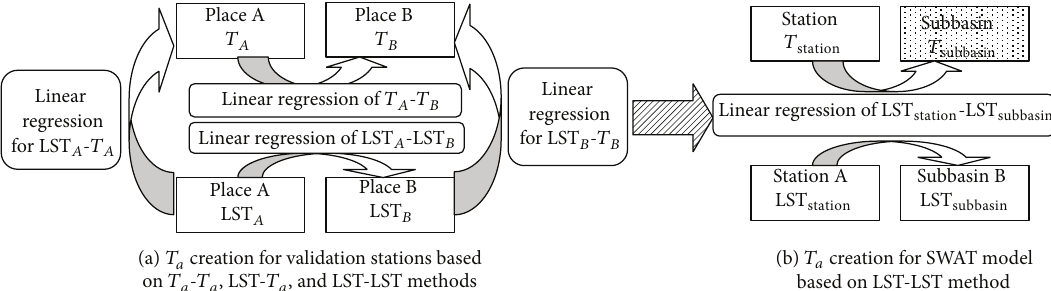
Figure 2: Diagram of 𝑇 𝑎 creation methods based on 𝑇 𝑎 and LST data for station validation and SWAT model.